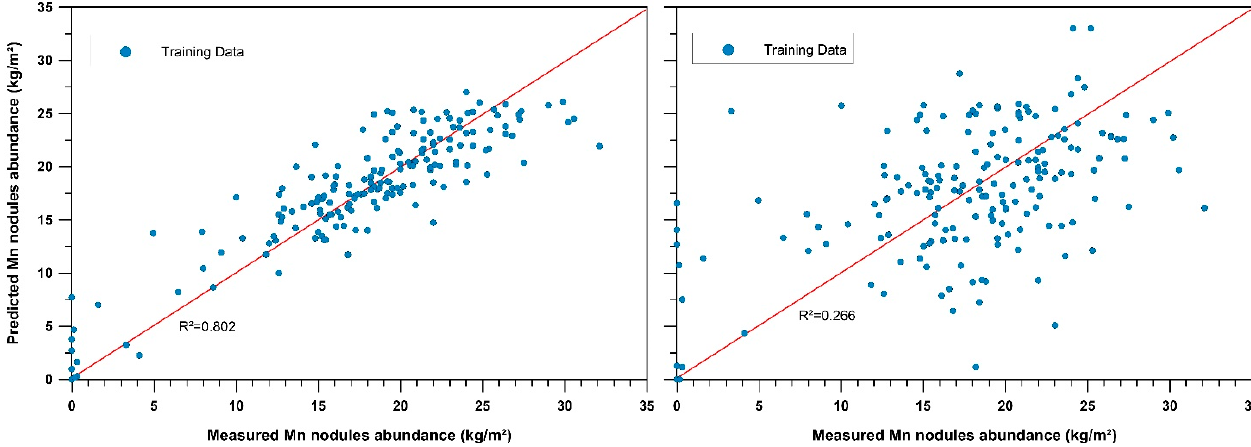
Figure 6. ( Left ): correlation between measured/observed vs. modelled/predicted manganese nodule abundance. ( Right ): leave-one-out cross-validation [6].